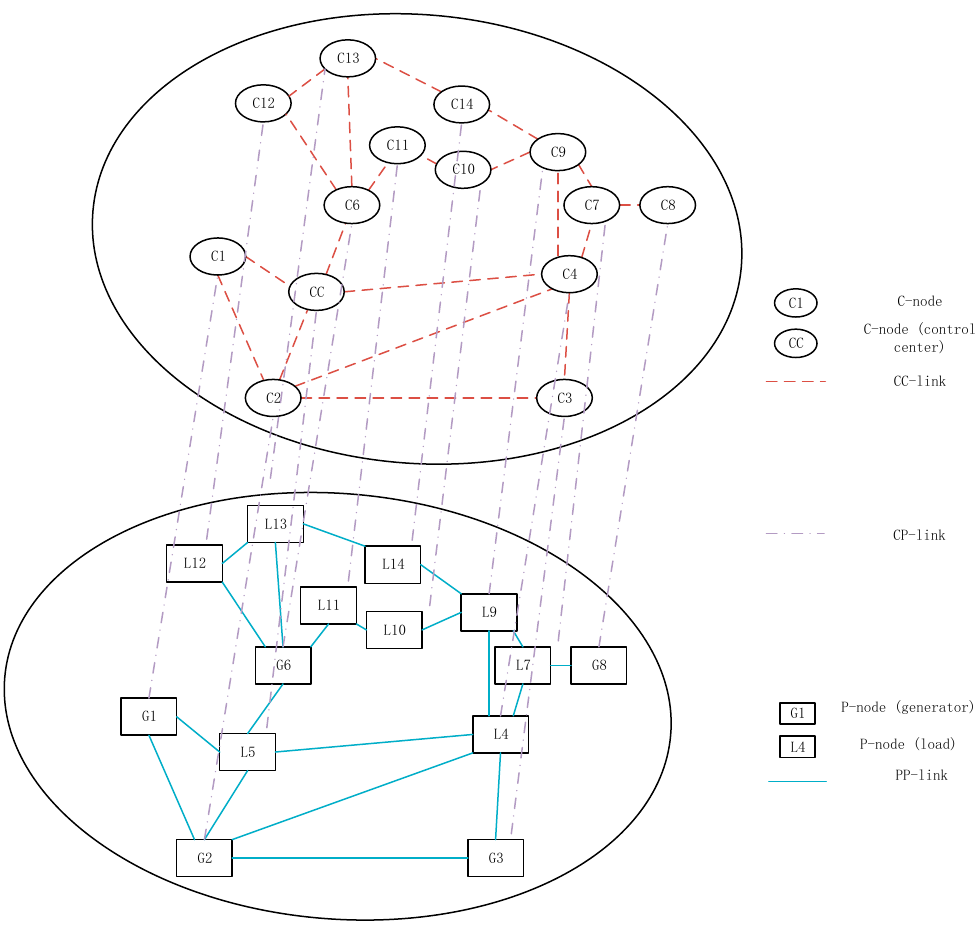
Figure 4. The modified IEEE 14-bus system.